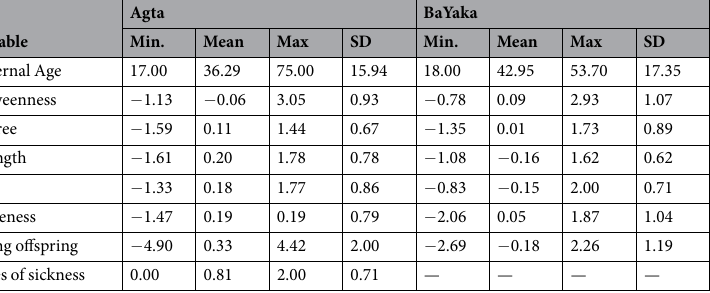
Table 1. Descriptive statistics for the sample for Agta mothers ( n = 39) and BaYaka mothers ( n = 38). All network centrality measures are z-scores to standardise the results per camp. Living offspring are residuals from an analysis between age and living offspring, 0 representing the average fertility of the age